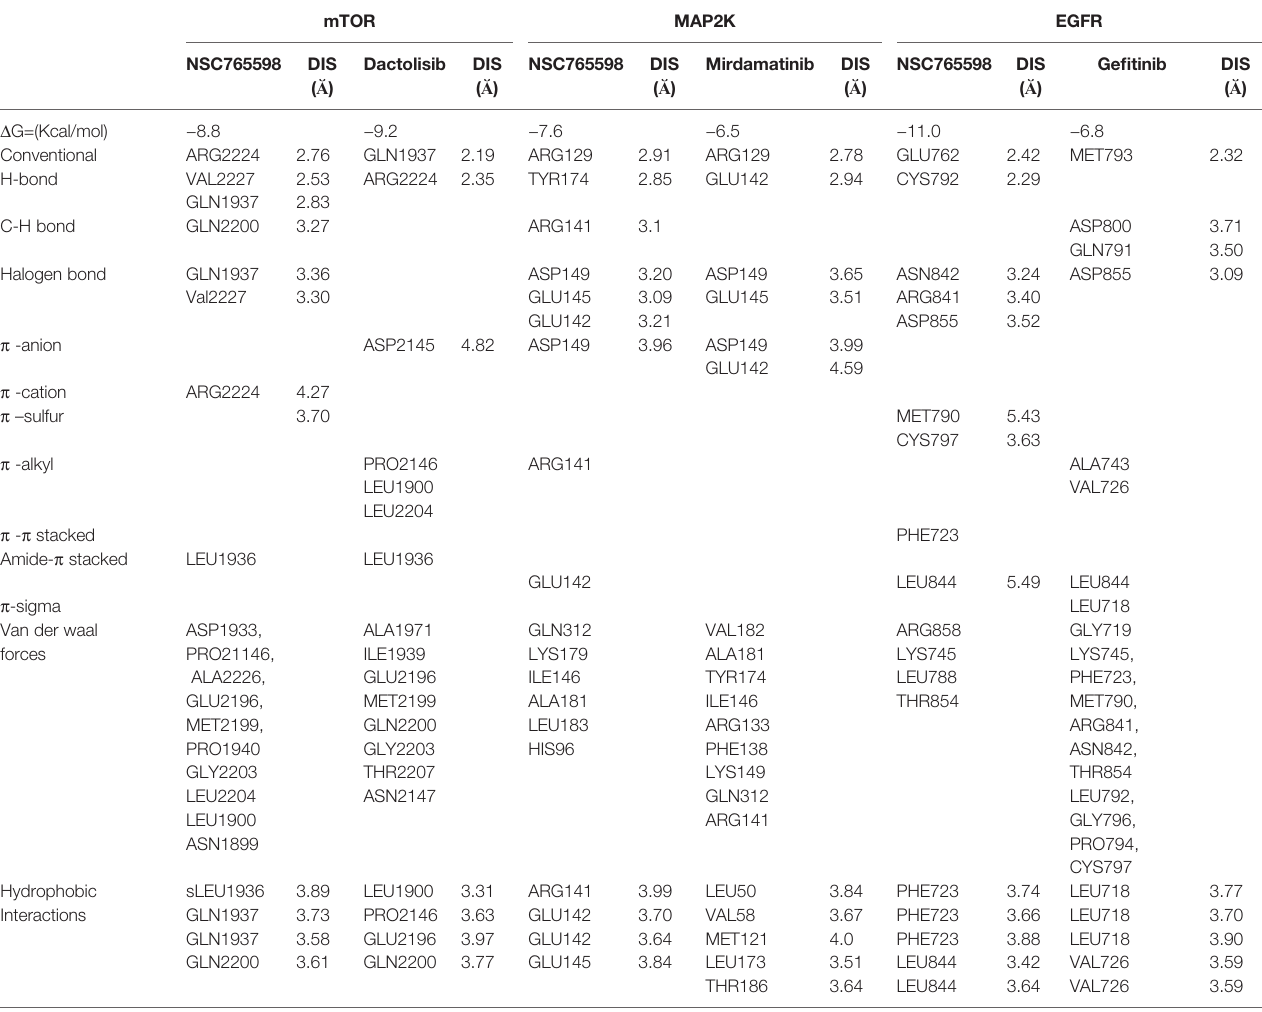
TABLE 3 | NSC765598 and standard drug comparative docking pro fi le against